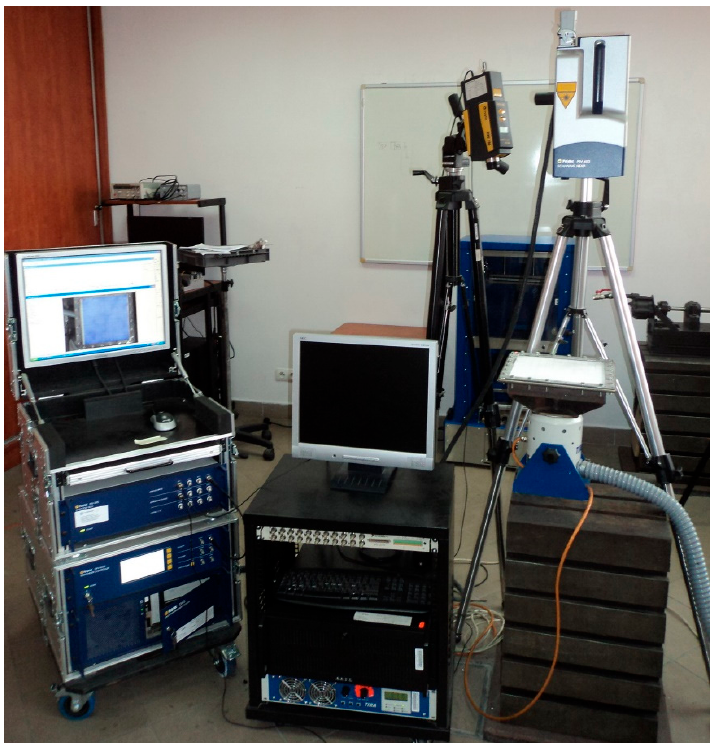
Figure 2. The experimental setup used for the acquisition of mode shapes [28] with permission from Elsevier.